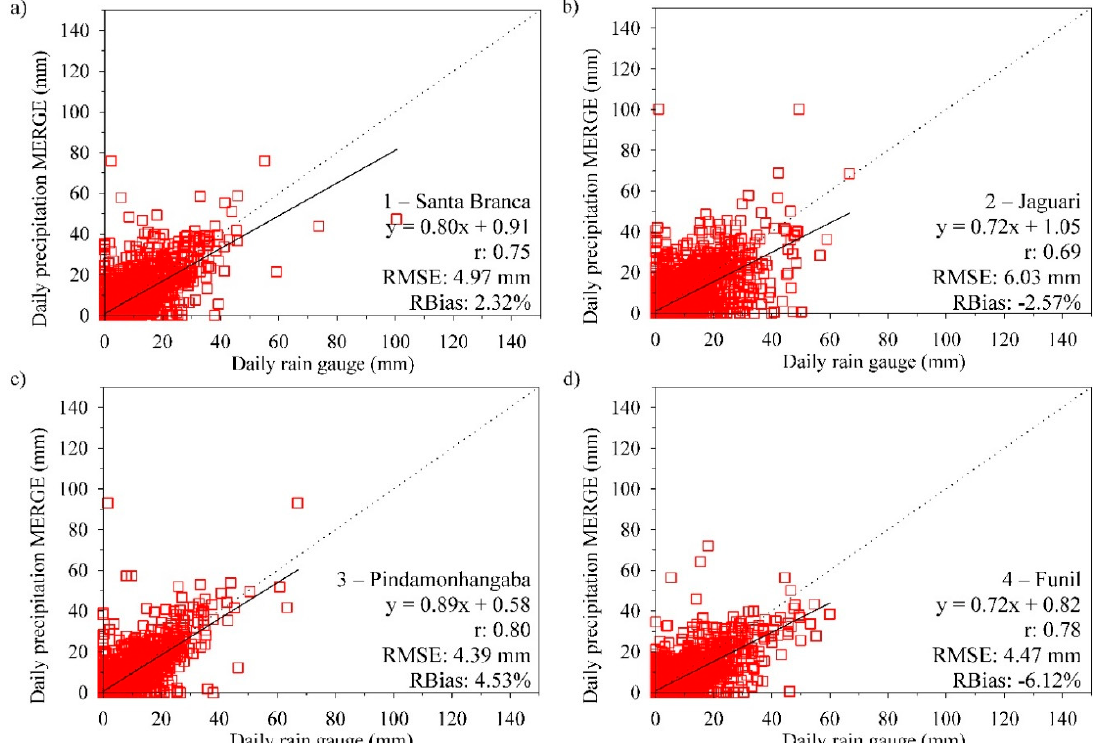
Figure 6. Scatterplot between daily MERGE and rain gauge data for watersheds ( a ) 1, ( b ) 2, ( c ) 3, and ( d )